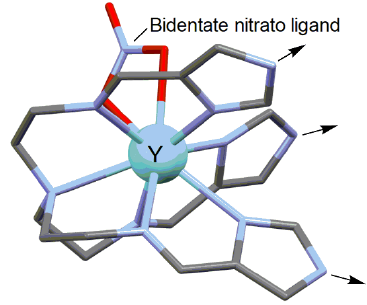
Figure 8. Schematic representation of the nine-coordinate, triply-deprotonated form of metalloligand 10 (the figure is derived from the crystal structure of its triply protonated form) [112]. The arrows indicate the distorted tripodal arrangement of the metalloligand’s coordination vectors prior to binding to a (secondary) metal ion centre.